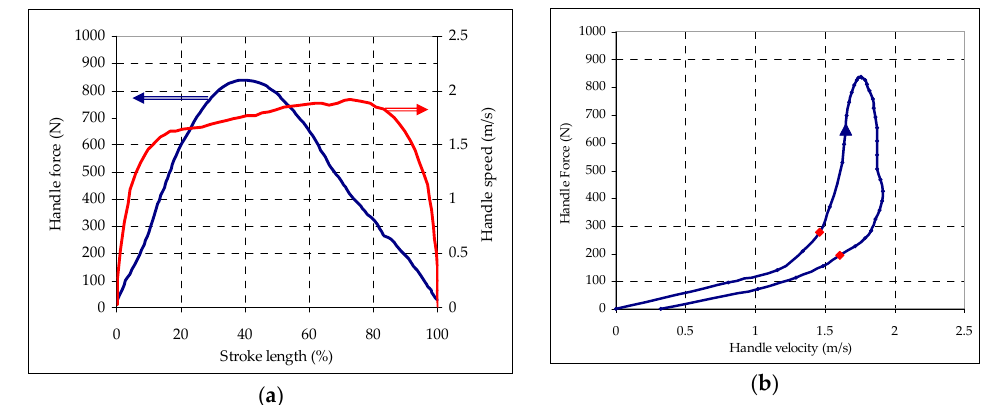
Figure 1. Concept2 ergometer rower force-speed relationships with raw data from Kleshnev [9]. Average of five female athletes, with a drive time of 0.97 s (32.1 strokes/min). ( a ) Handle force (N) and speed (m/s); ( b ) Force-speed relationship. The arrow shows the time progression direction, and the red markers, the first and last 10% of the stroke length (where the handle speed is less than the corresponding fan flywheel rotation velocity).